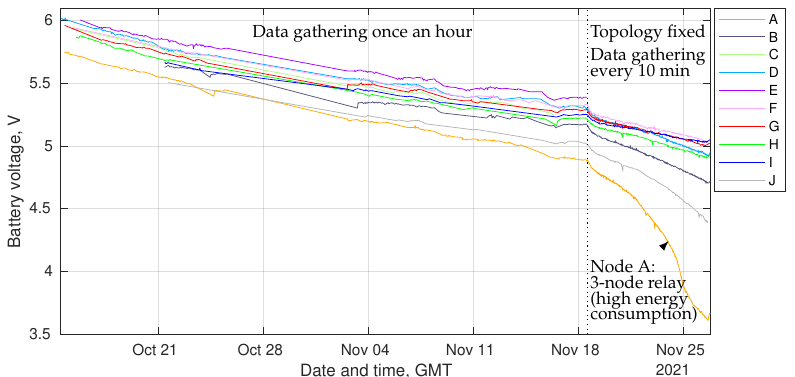
Figure 28. Sensor node battery voltage timeline throughout the North Sea